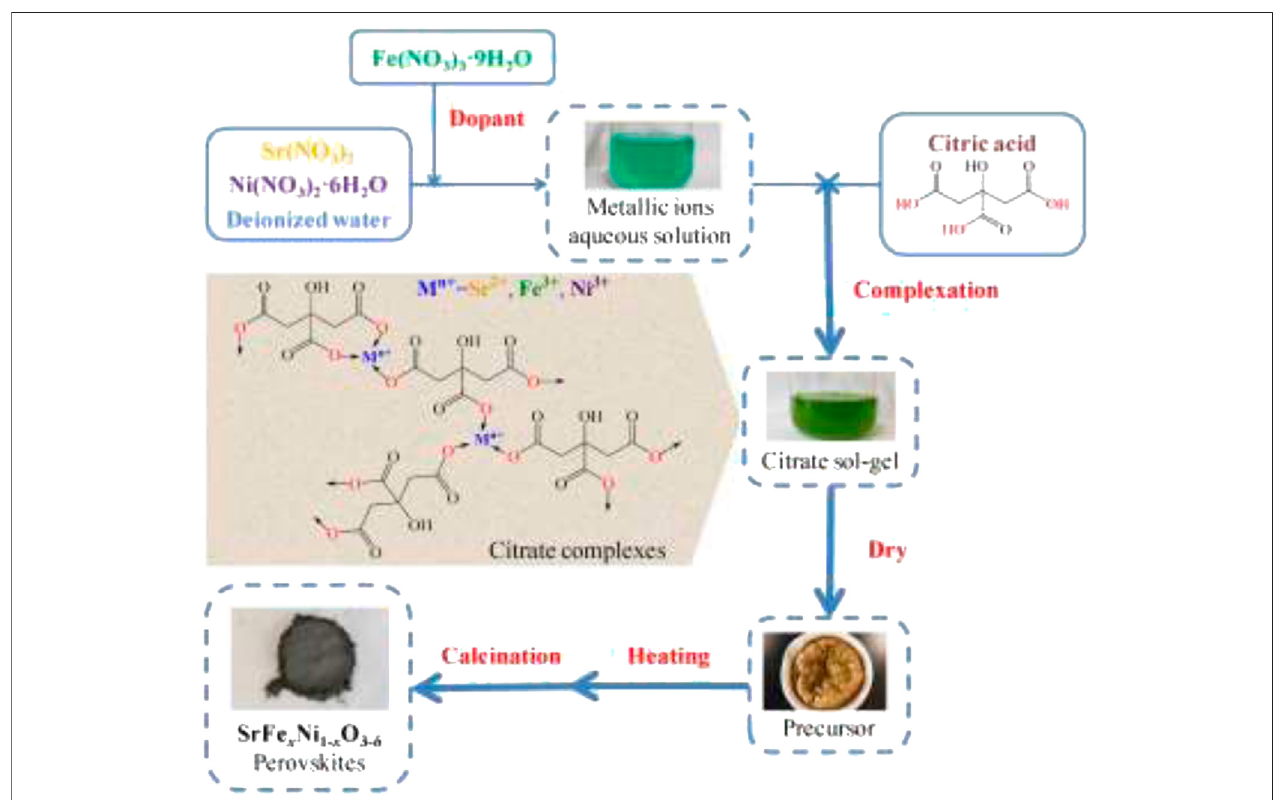
FIGURE 3 | Schematic diagram of the fabrication process of the SrFe x Ni 1-x O 3 - δ perovskites (Zhang Y. et al., 2019).